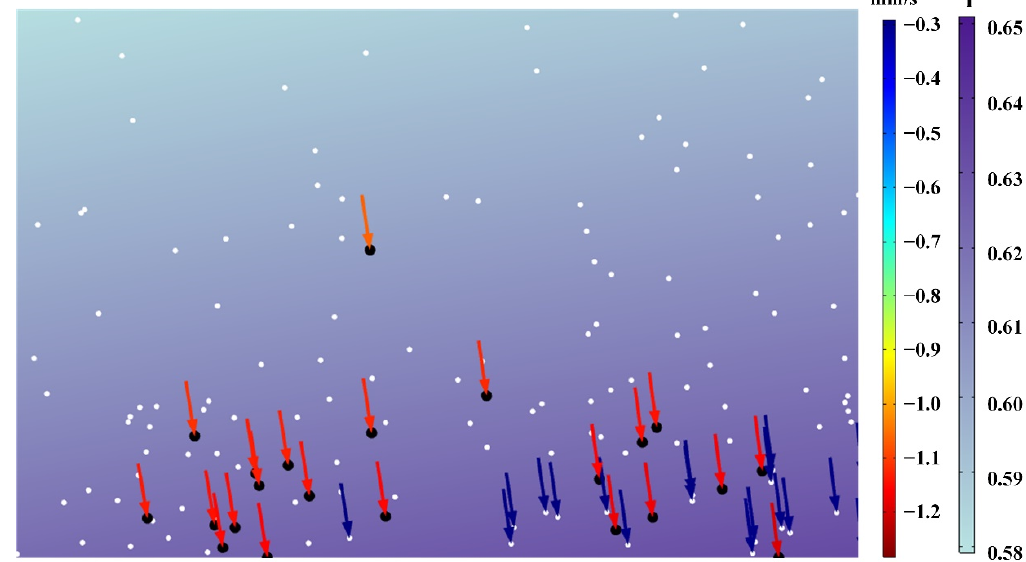
Figure 8. Distribution of particles with different sizes.